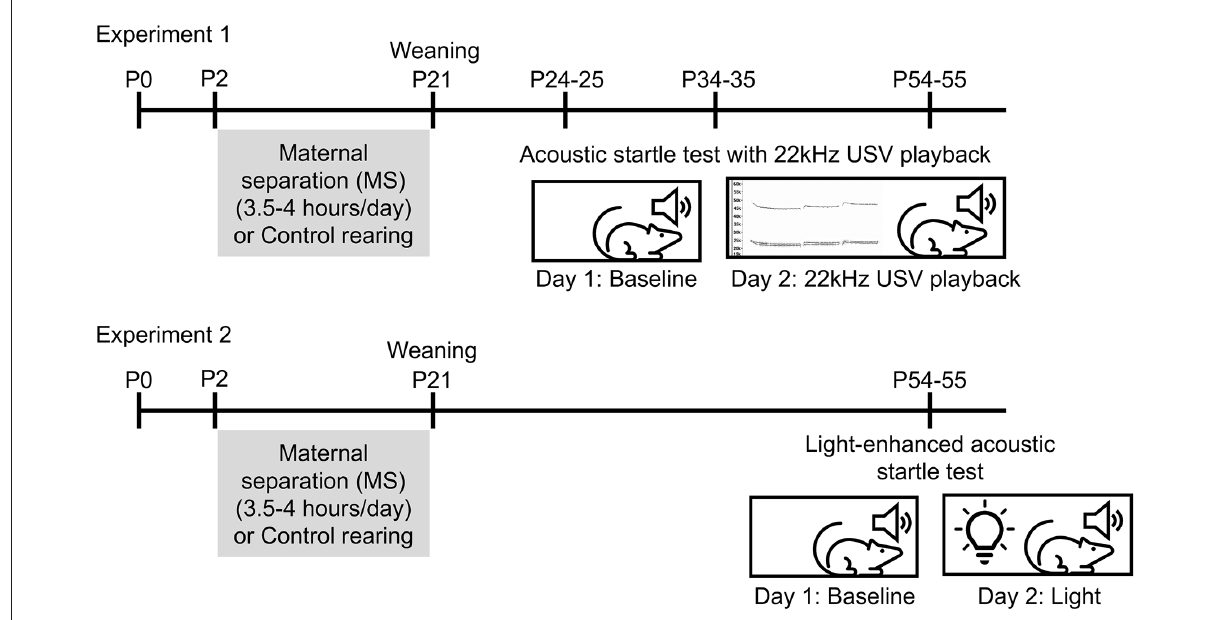
FIGURE1 Experimental timelines. In Experiment 1, rats underwent maternal separation (MS) or control rearing from P2 to 20 until weaning on P21. Separate cohorts of rats underwent the acoustic startle test with 22 KHz USV playback on either P24–25, P34–35, or P54–55. In Experiment 2, rats underwent MS from P2 to 20 and were tested in light-enhanced startle on P54–55.